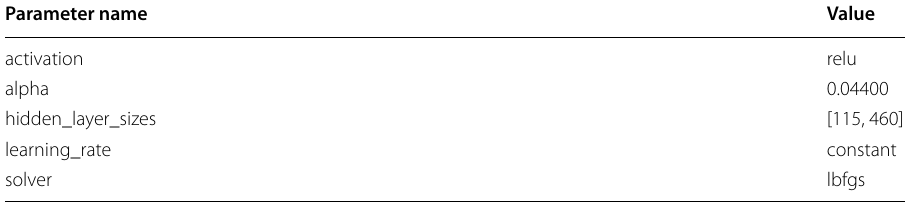
Parameter values for classifier yielding best results in terms of AUC Table 99 Modes of MLP tuned hyperparameter values for experiments with the keylogging dataset